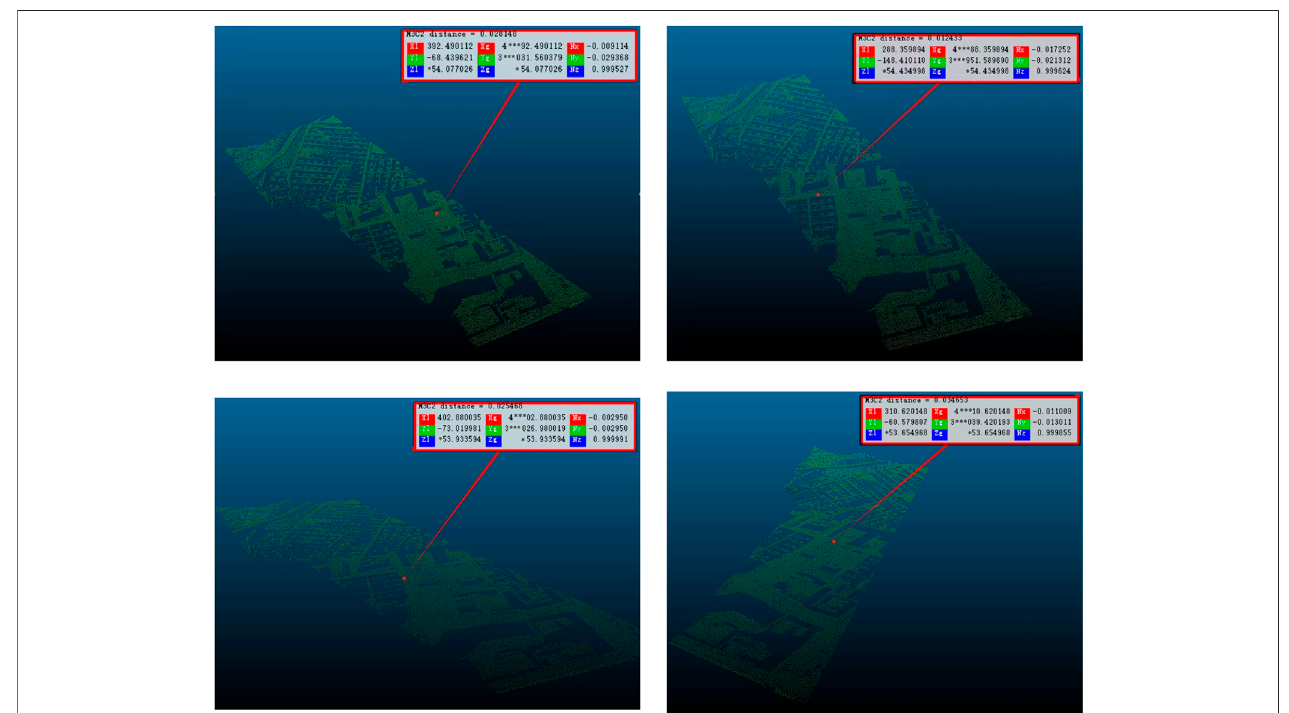
FIGURE 12 | Subsidence values of surface.